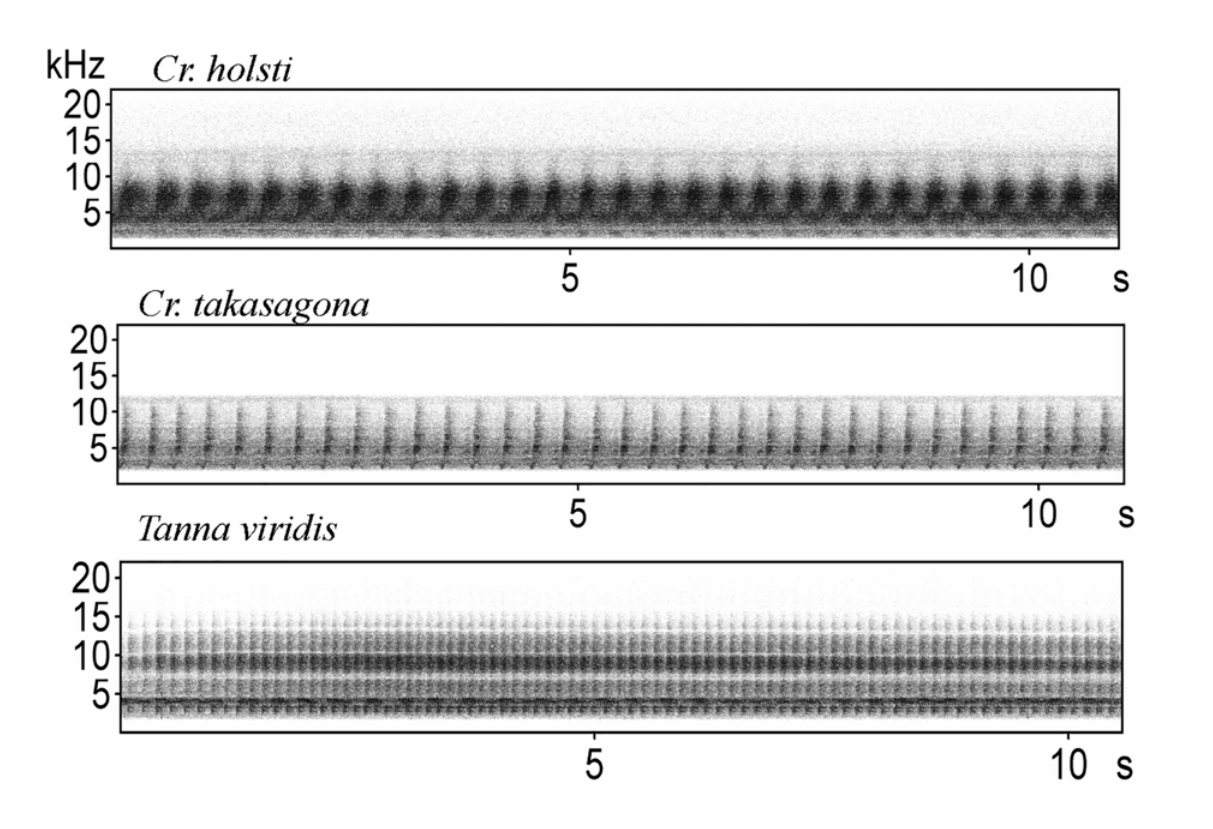
Figure 2. Spectrograms of cicada calling songs of pulse trains